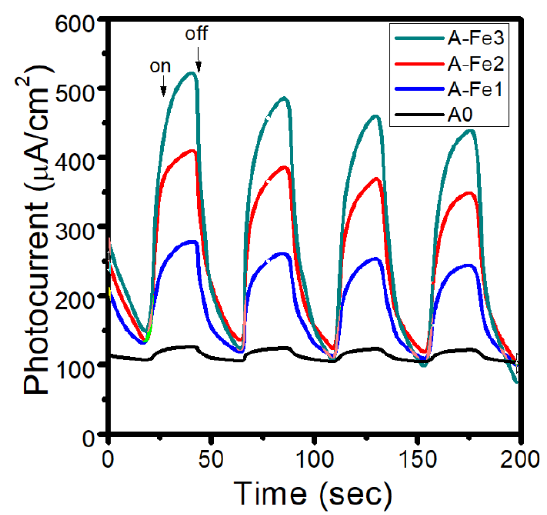
Figure 5. Chronoamperograms over 200 s (at 0.80 V (vs. Ag/AgCl) in solution Na 2 SO 4 adjusted to pH 2, with and without light illumination (100 W of halogen lamp), of flexible FTO slides coated with control thin films comprising of PANi A0, A-Fe1, A-Fe2 and A-Fe3.